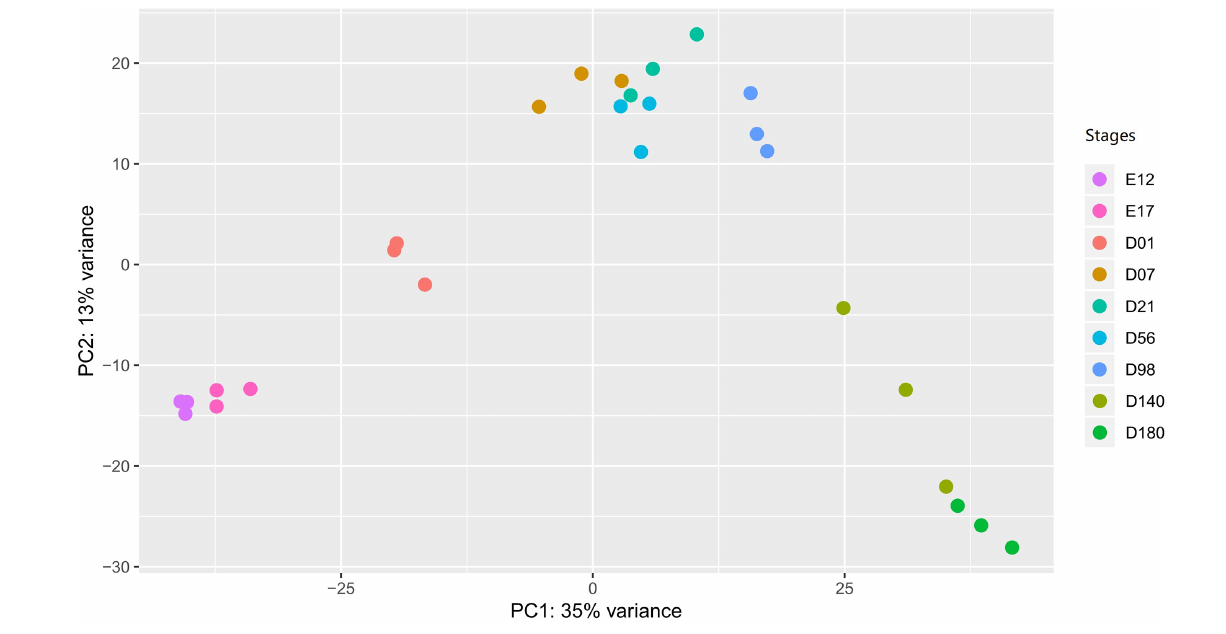
FIGURE 2 | The PCA plot of liver samples in different developmental stages. In the stages, E stands for the embryonic period, and the D stands for the day after hatching. PCA, principal component analysis.